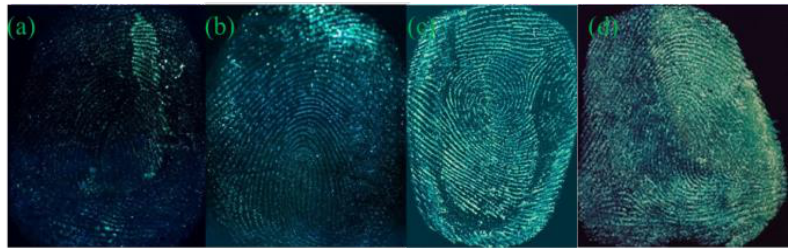
Figure 3. Fingermarks developed by G-CDs on various substrates. ( a ) sealed bag; ( b ) coverslip; ( c ) transparent tape; ( d ) tin foil paper.